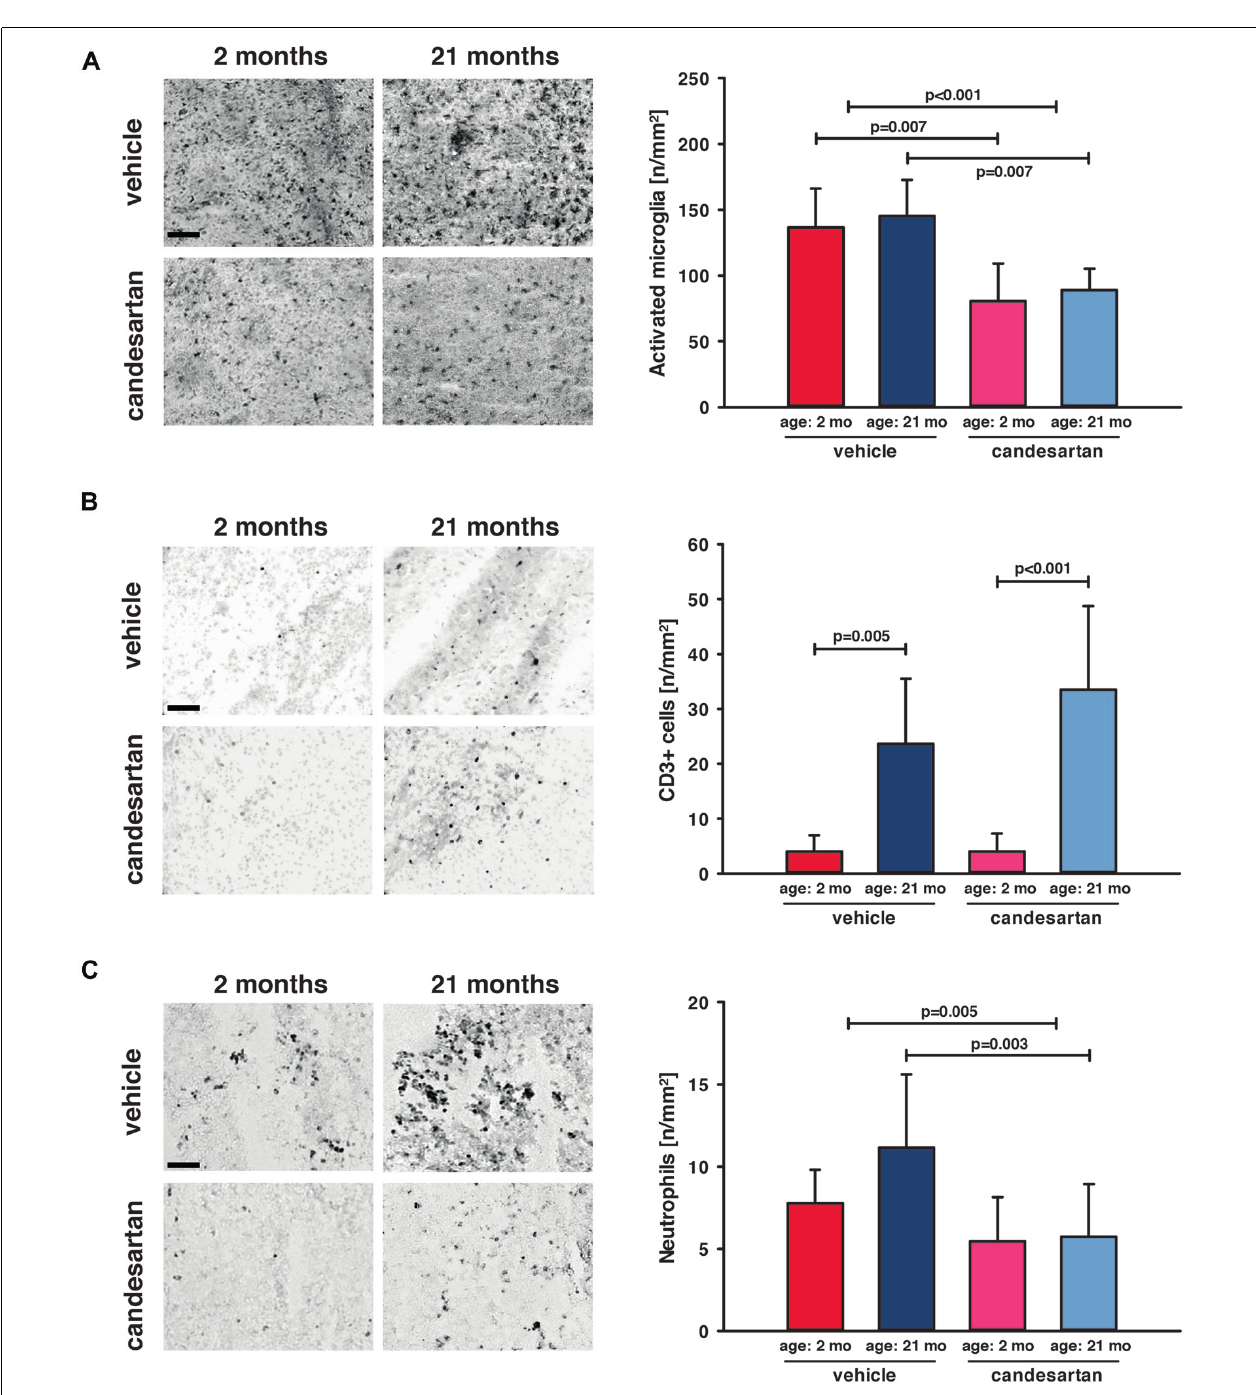
FIGURE 4 | AT1 inhibition reduced cerebral inflammation in young and old mice. Microglial activation and leucocyte infiltration were analyzed 5 days after brain injury. In the left column are representative immunohistochemistry images of stained sections of each age and treatment group (scale bar: 100 µ m): Iba-1 (A) as a marker for activated microglia, CD3 + ( B ) as a marker for T-lymphocytes and Gr1 (C) as a marker for neutrophil granulocytes. In the right column, the results are presented as the number of cells/mm 2 (n/mm 2 ). Candesartan treatment reduced microglial activation in both age groups and did not affect T-lymphocyte infiltration. Aged mice showed a higher level of T-lymphocyte infiltration than young mice, independent of treatment. Invasion of neutrophil granulocytes was reduced in both age groups taken together and in old mice by candesartan treatment. However, the reduction of neutrophil granulocyte infiltration did not reach a level of significance in young candesartan-treated mice. For better illustration of data different colors were used for each group (2 months: dark red = vehicle, light red = candesartan) and old mice (21 months: dark blue = vehicle, light blue = candesartan treatment); young: vehicle and candesartan ( n = 8 each); old: vehicle ( n = 10; seven survived) and candesartan ( n = 8; seven survived); two-way ANOVA with Holm-Sidak’s multiple comparisons test; data is presented as mean ± SD.